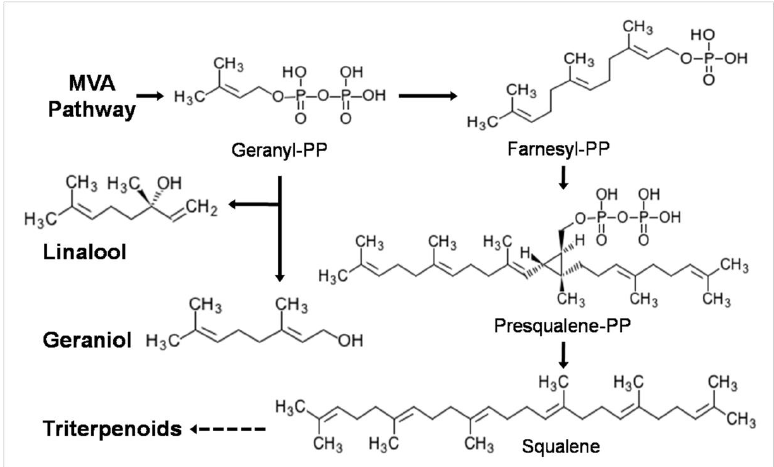
Figure 4. Biosynthetic pathway of main essential oil monoterpene components and triterpenoids in P. cocos